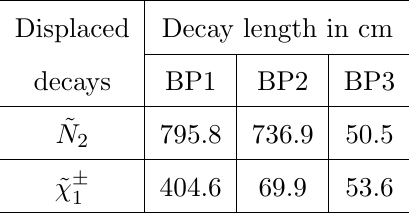
for the benchmark 1